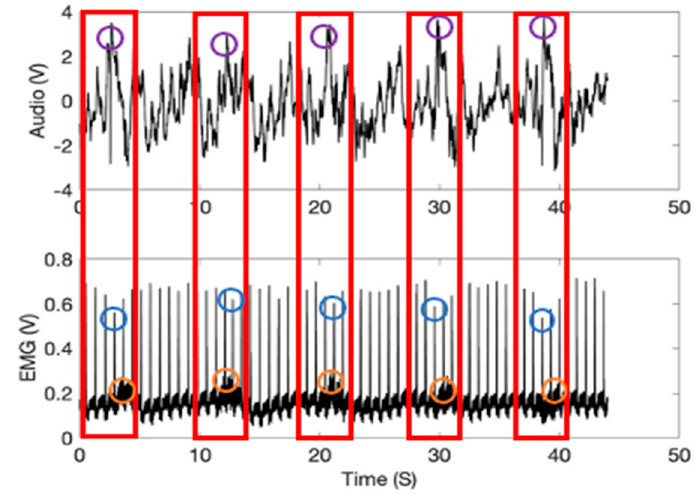
Figure 3. The time and amplitude characteristics of normal lung sound and EMG signals obtained from the diaphragm muscle location (1000 mL tidal volume; one breathing cycle: 4-s inspiration (red box) and 4-s expiration).